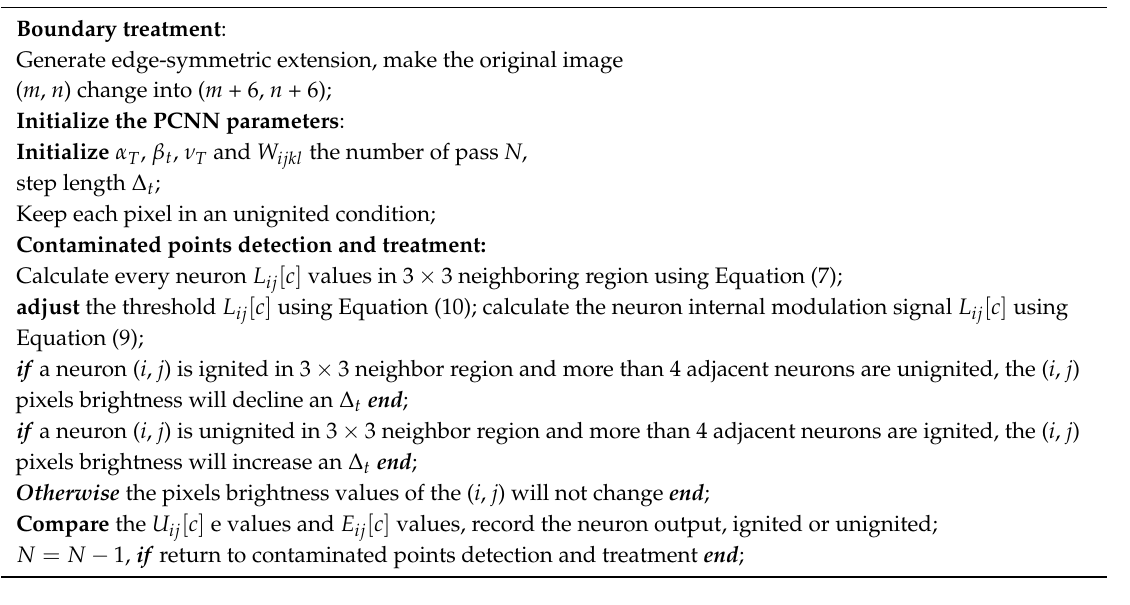
Algorithm 1 PCNN Noise Reduction